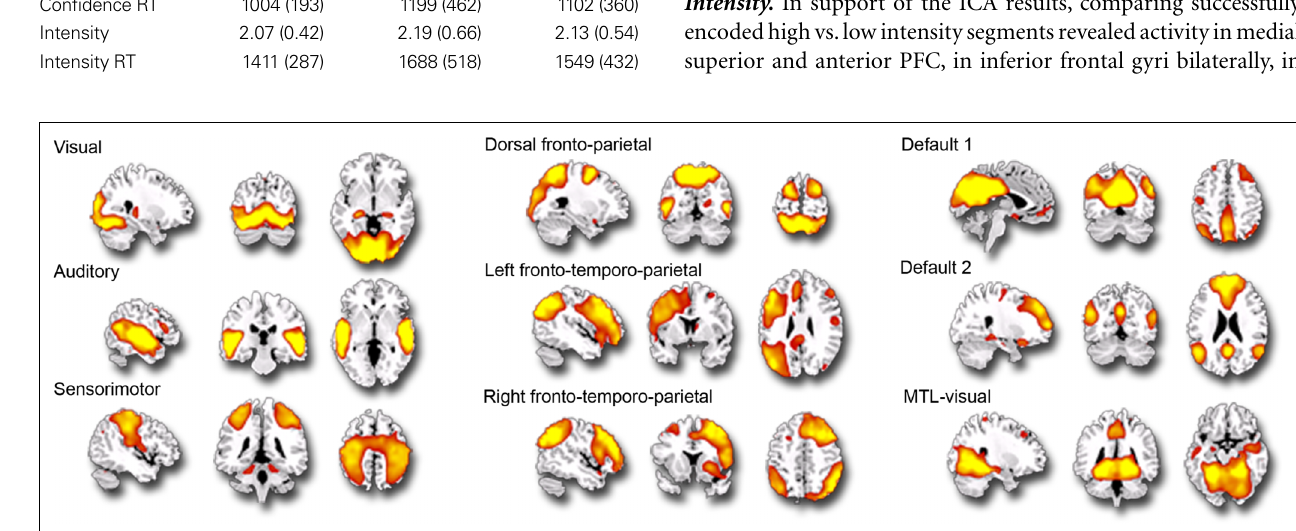
FIGURE 1 | Independent components (ICs) identifi ed during the free viewing of the 35-min portion of the basketball game ( p = 0.001; k = 5). This fi gure represents the 9 IC spatial maps identifi ed, each overlaid on the sagittal, coronal and axial planes of an anatomical template.